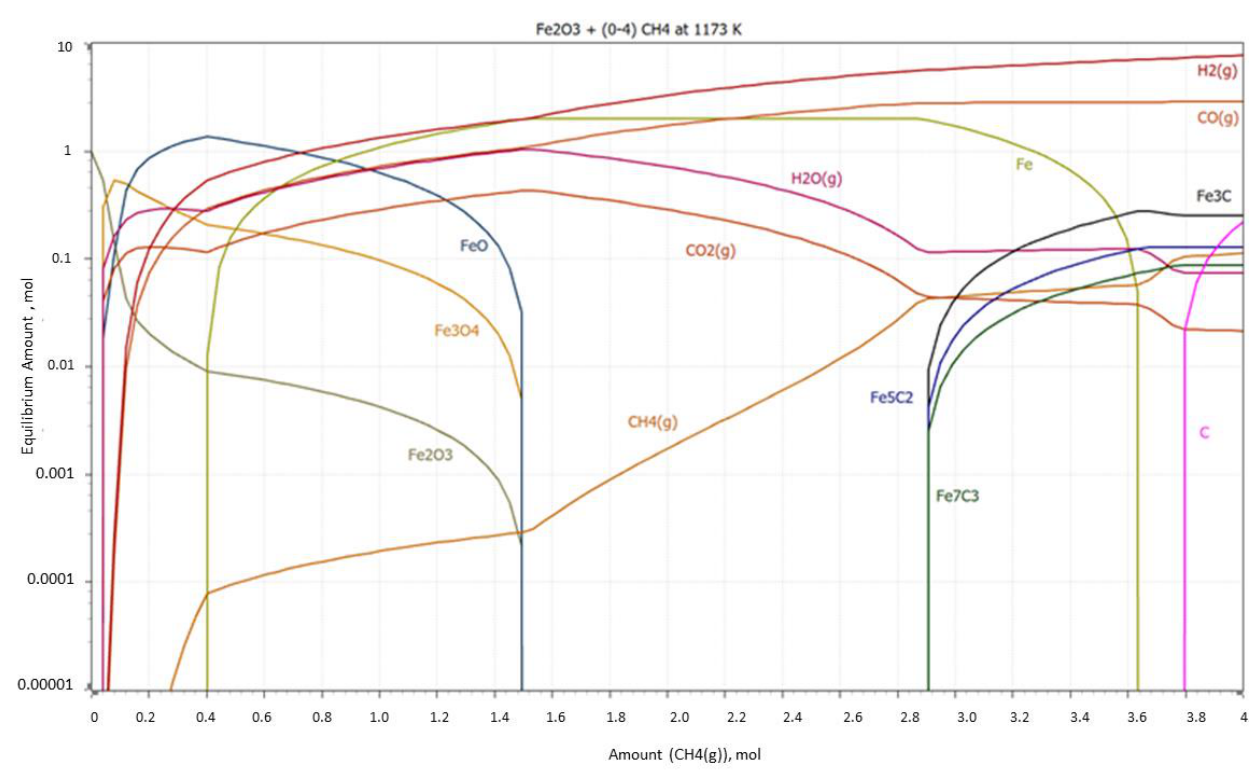
Figure 12. Equilibrium calculations when 1 mole of Fe 2 O 3 reacts with CH 4 at 1173 K. Created using the equilibrium calculations module in HSC Chemistry 9.